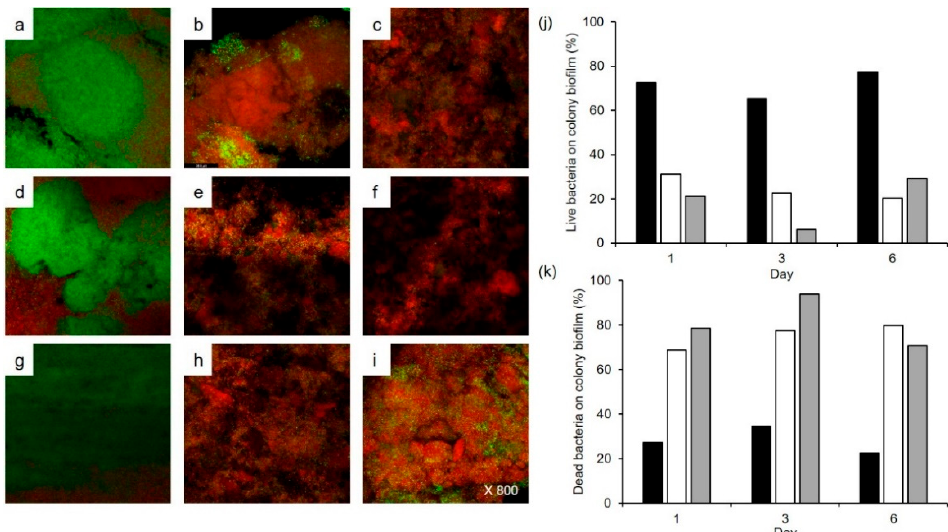
Figure 3. Effects of W. cibaria CMU and CMS1 on multi-species biofilm during co-culture at 1, 3, and 6 d observed using confocal laser scanning microscopy to visualize live/dead bacteria. ( a – c ) Control, W. cibaria CMU-treated, and CMS1-treated for 1 d, respectively; ( d – f ) control, W. cibaria CMU-treated, and W. cibaria CMS1-treated for 3 d, respectively; ( g – i ) treated control, W. cibaria CMU-treated, and W. cibaria CMS1-treated for 6 d, respectively. Magnification, 800×. ( j ) Percent live bacteria on colony biofilm; and ( k ) percent dead bacteria on colony biofilm. Black bar, control; white bar, W. cibaria CMU-treated; grey bar, W. cibaria CMS1-treated.